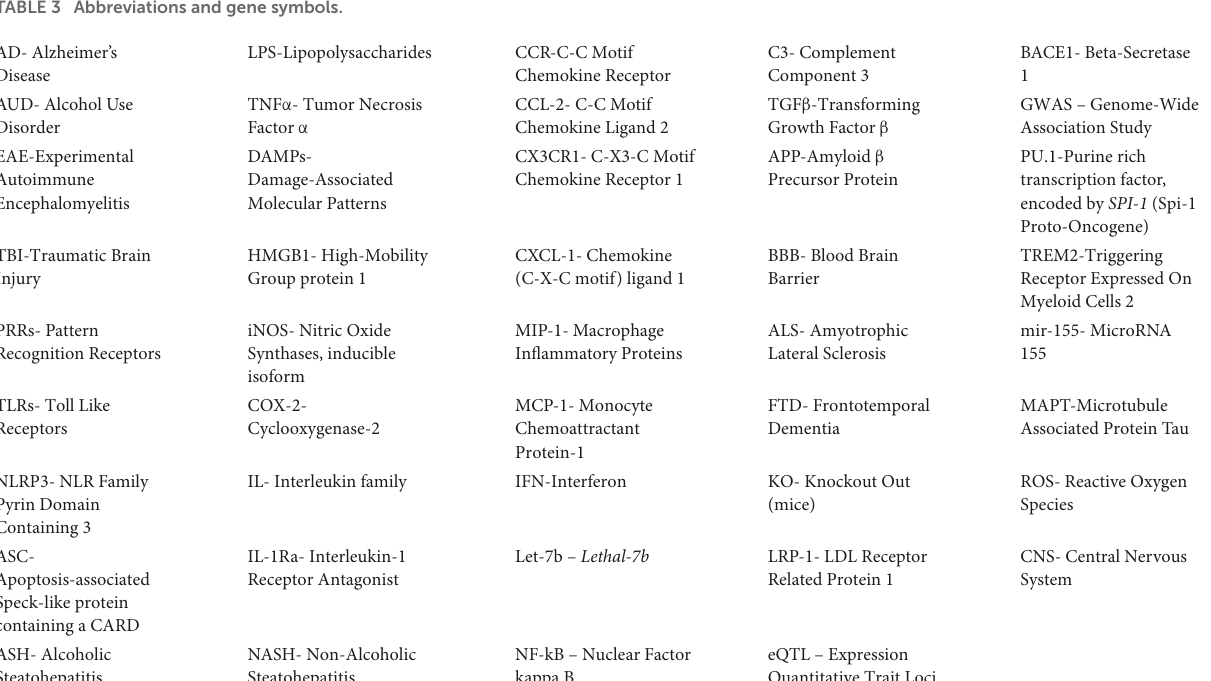
TABLE 3 Abbreviations and gene